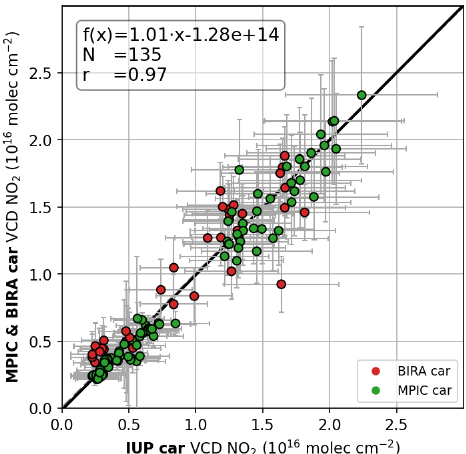
Figure A5. Scatter plot between co-located car DOAS measure- ments ( ± 5min time window) of MPIC and BIRA car DOAS data vs. IUP car DOAS tropospheric NO 2 VCDs averaged within 200m × 200m grid boxes and 5min time intervals. The data points from the BIRA and MPIC car DOAS instrument are color coded in red and green, respectively. The thick solid black line repre- sents the orthogonal distance regression. Error bars represent the error in the tropospheric NO 2 VCD retrieval, averaged within the 200m × 200m grid boxes and 5min time intervals.